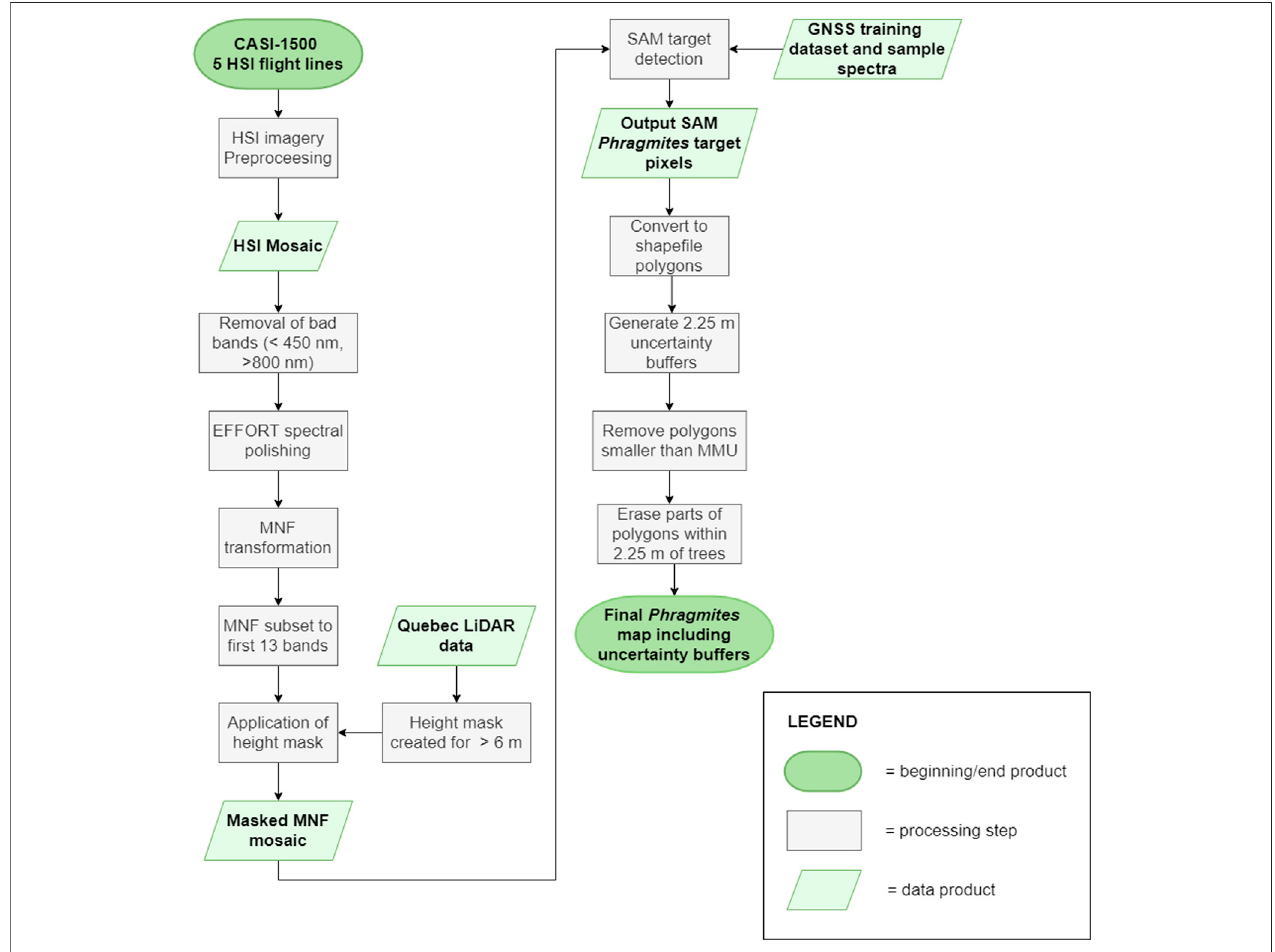
FIGURE3| Adetailed fl owchartshowingtheairborneHSIandtargetdetectionmethodologystepsusedtogeneratethe fi nalmapof Phragmites includingtheerrorbuffers.